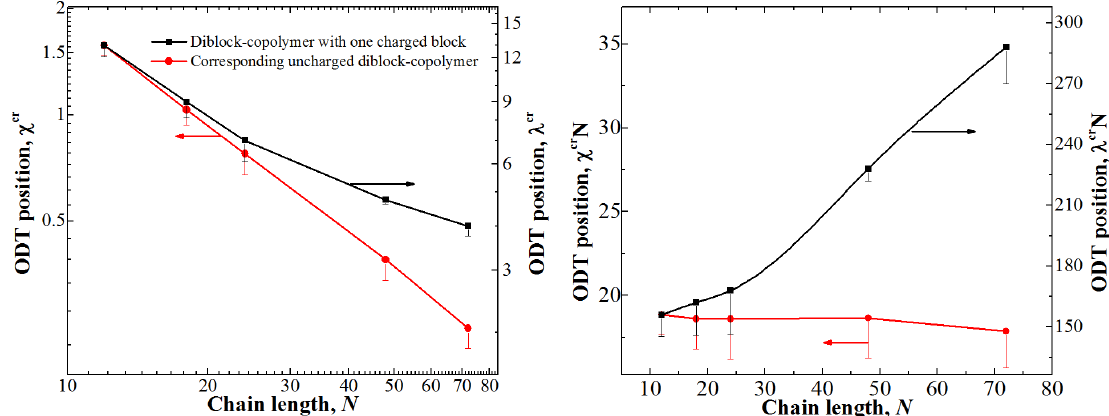
Figure 3. Positions of the ODT for diblock-copolymers with one charged block and corresponding uncharged diblock-copolymer at ϕ = 0.5 depending on the chain length. The left graph shows λ cr (for diblock-copolymers with one charged block) and χ cr diblock-copolymers), while the right shows the products λ cr N and χ cr chosen so that they show the same relative increase of the interaction